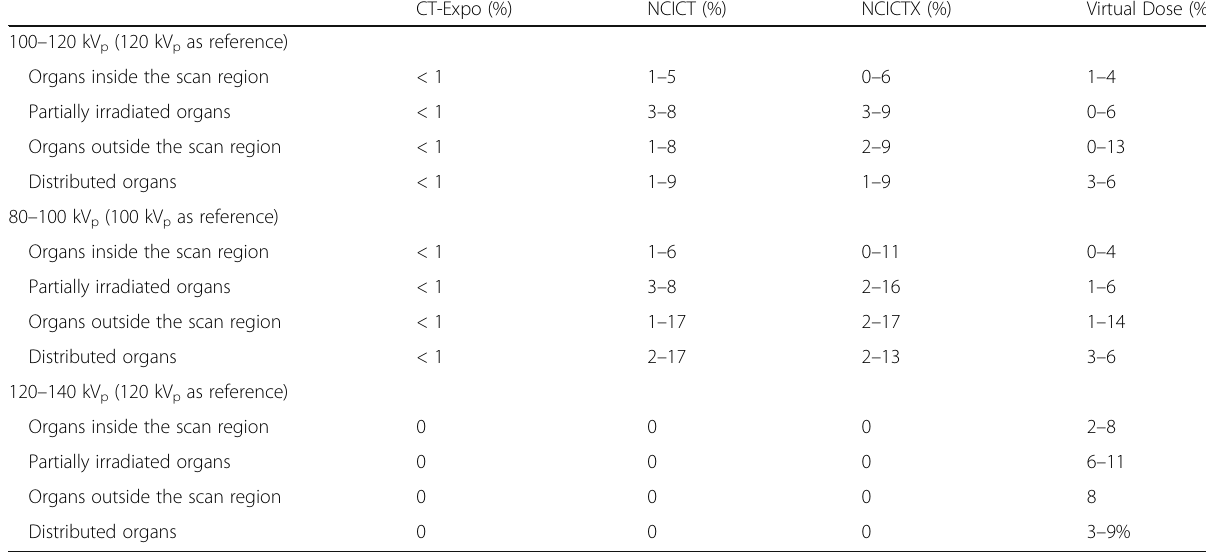
Table 3 Organ dose variation according to tube voltage. We compared 100 and 120 kV p , 80 and 100 kV p , and 120 and 140 kV p keeping as reference respectively 120, 100, and 120 kV p . For each organ implemented in the four software studied, we calculated the discrepancies as difference of the values obtained for each couple of voltages. These discrepancies are then normalised to the organ dose at reference voltage. We reported here only the minimum and the maximum values of discrepancy found for each class of organs subdivided according to the position relative to the scan region